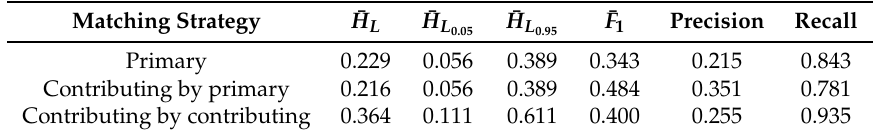
Table 2. Cause match accuracy for the nearest neighbor found in the training corpus between documents in the LSA space. ¯ H L indicates the Hamming loss for the lower 5% of cases in the query set. 0.05 Matching